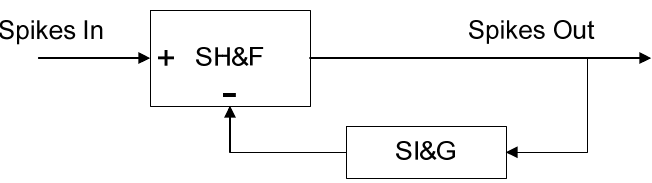
Figure 12. Spikes Temporal derivative